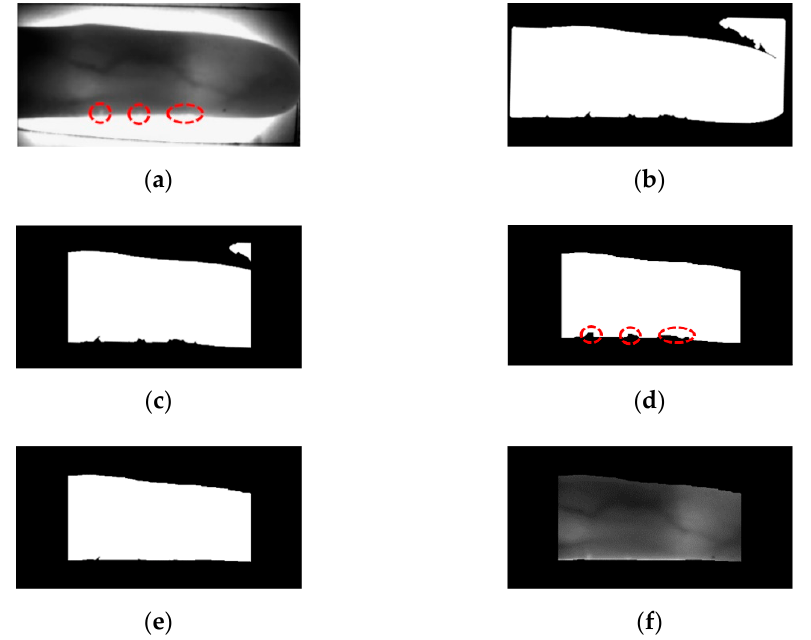
Figure 3. Extracting finger-vein ROI: ( a ) original finger image, ( b ) in-plane rotation compensation, ( c ) left and right areas removal, ( d ) component labeling, ( e ) ROI mask after filling black area of finger region, and ( f ) obtained ROI